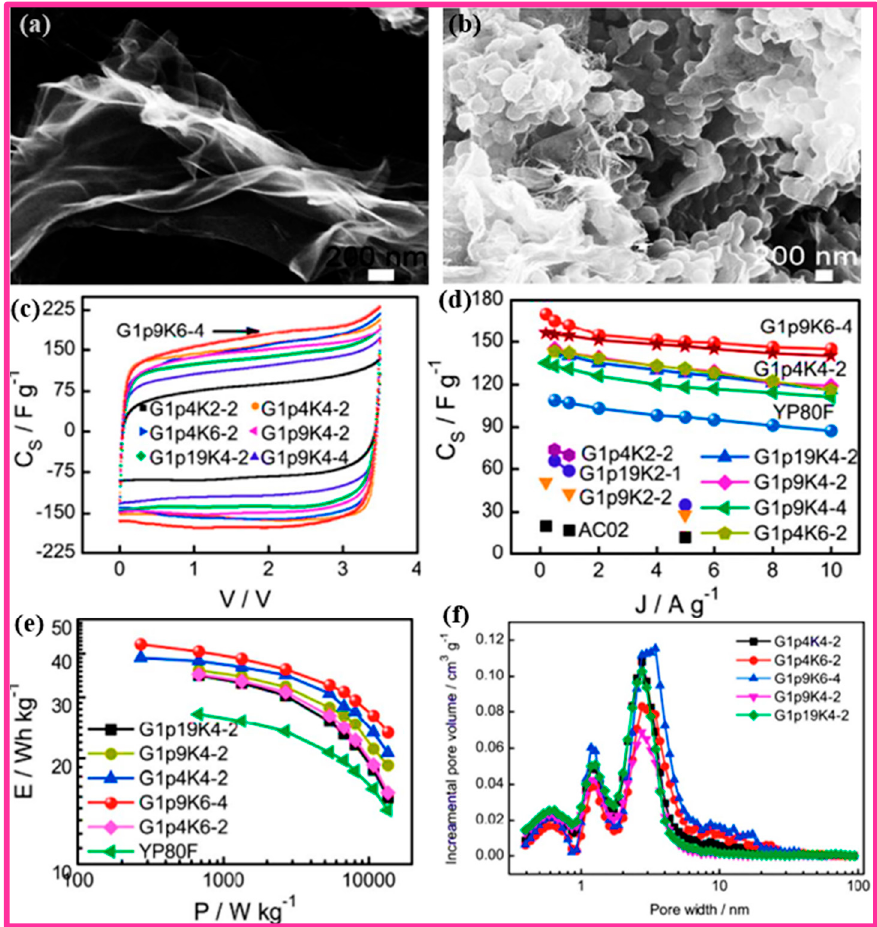
Figure 9. SEM images of the samples ( a ) G1p4K4-2, and ( b ) G1p9K6-4, ( c )The CV curves illustration for the HSG device electrodes at a scan rate of 20 mV.s − 1 . ( d ) The specific capacitance of the various samples in different densities, for the HSG device with the TEABF4 as the electrolyte. ( e ) Ragone plot for the HSG device including the propylene carbonate + TEABF4, as electrolyte material. ( f ) The pore size distribution of the HSG electrode material samples. Reprinted with permission from [139], Copyright 2015, Royal Society of Chemistry.